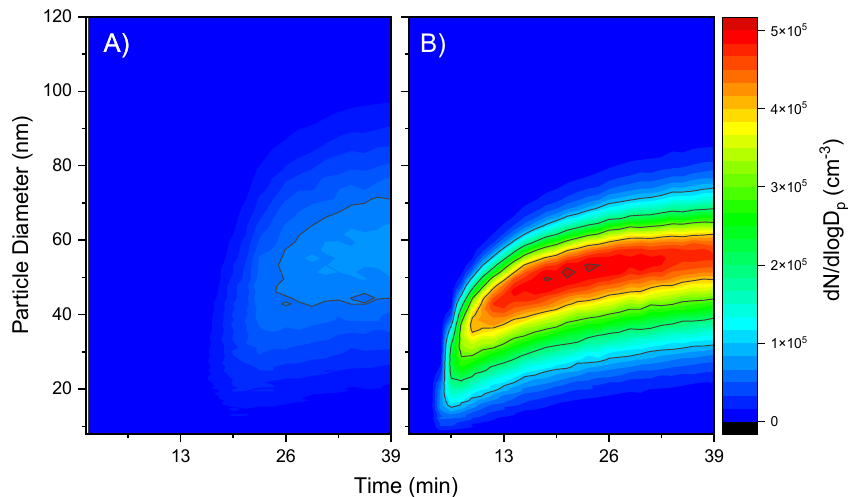
Figure 1. Evolution of OA particle size distributions for dark ozonolysis of 6-ppb v α -pinene under ( A ) dry (<1%RH) and ( B ) humid (60%RH) conditions. ξ O3 = 500 ppb v . Table 3. Parameters for all chamber experiments reported herein pertaining to α -pinene. In all cases, chamber temperature was 20 (±1) °C. N max and C SOA,max are the maximum number of particles and SOA mass, respectively, formed in the experiment. Note: error bounds were estimated based on replicate (n = 4) measurements made in experiments aP 6 RH 0 and aP 6 RH 60 .